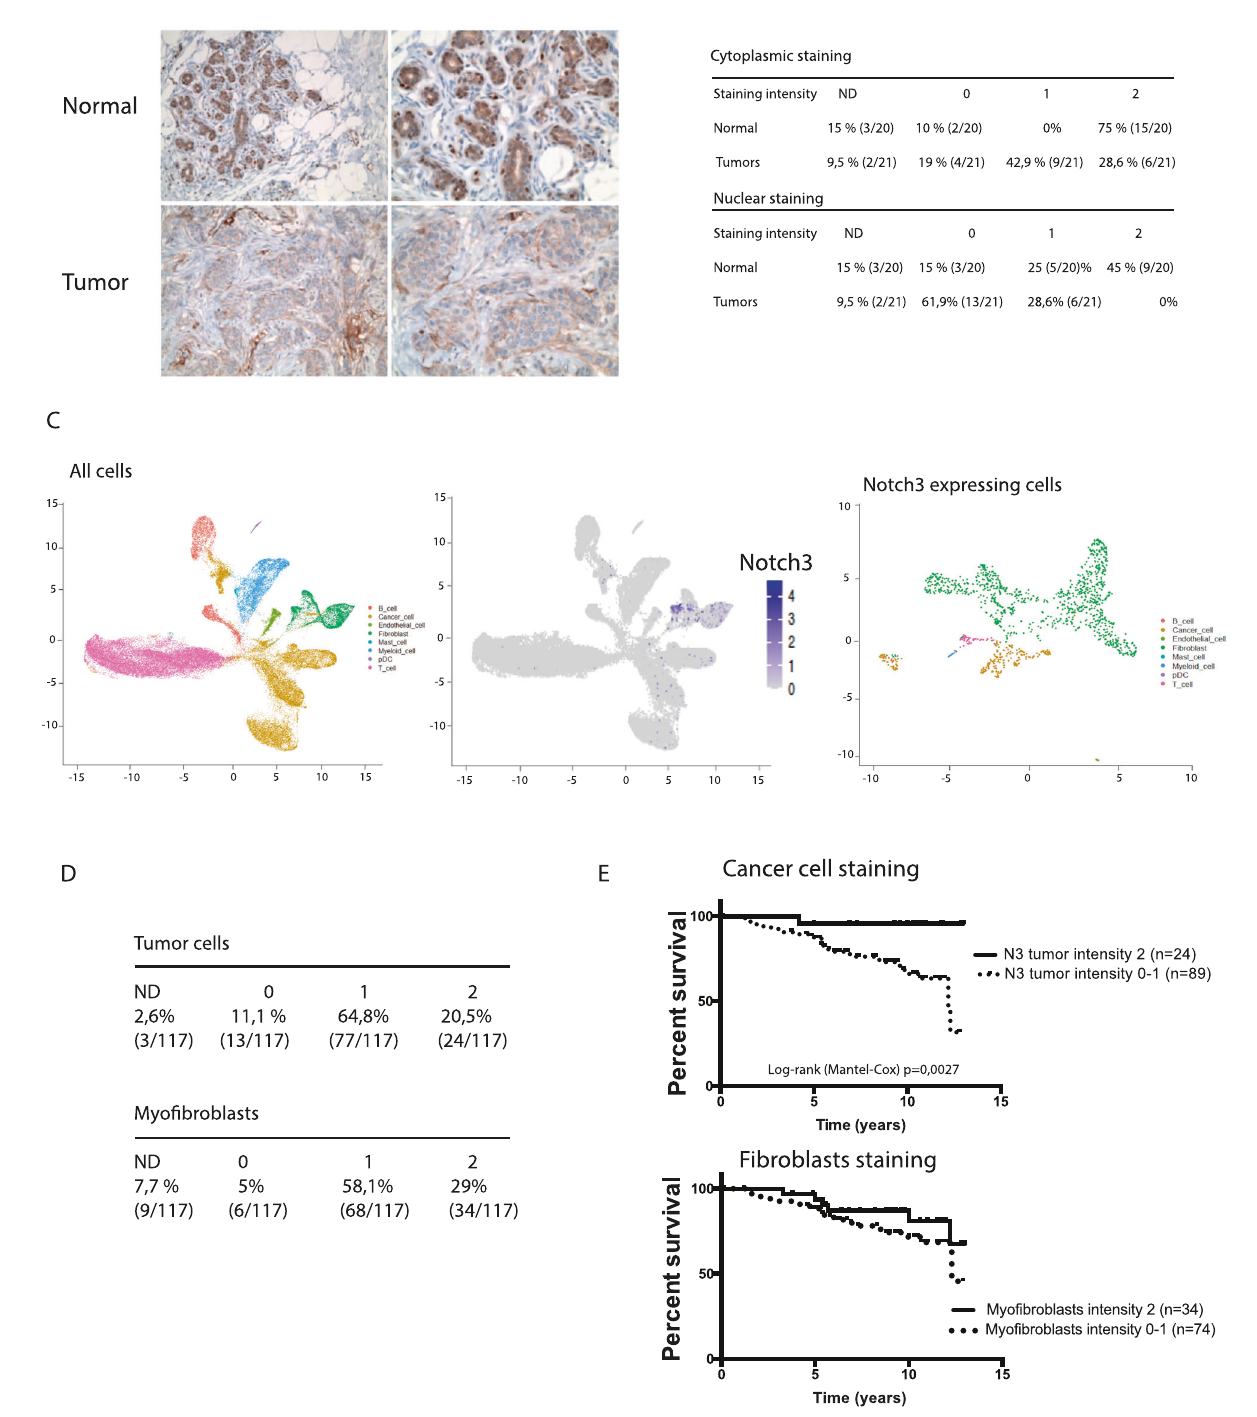
Fig. 1 Notch3 is lost and of good prognosis in breast cancers. A Immunohistochemistry of Notch3 expression (Notch3 D11B8 Cell Signaling antibody) in normal or tumor tissue. B Quanti fi cation of Notch3 staining in cancer cells of 21 in fi ltrating Breast cancer and adjacent histological normal tissu. C Analysis of Notch3 expression in breast cancer in single-cell data from Bassez et al. D Repartition of Notch3 staining intensity in cancer cells and myofobroblasts in a TMA of 117 breast cancer patients. E Kaplan – Meier plot of 117 patient ’ s survival depending on Notch3 expression localization: cancer cells or fi broblasts (TMA cohort).